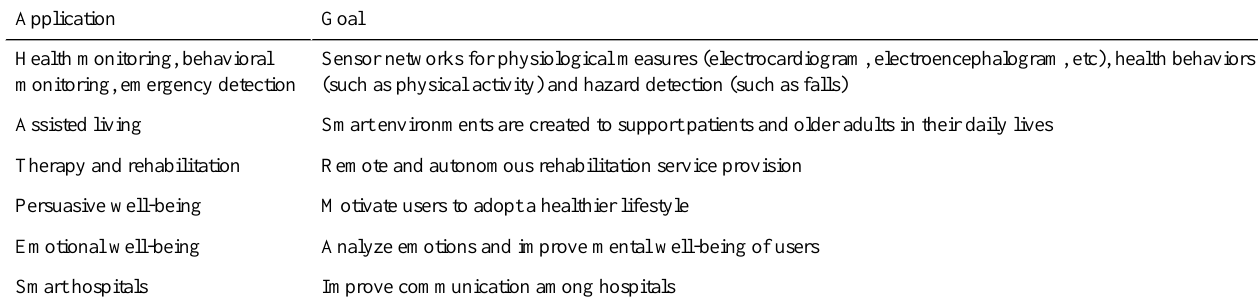
Table 1. Summary applications of Internet of Things–enabled technologies in health